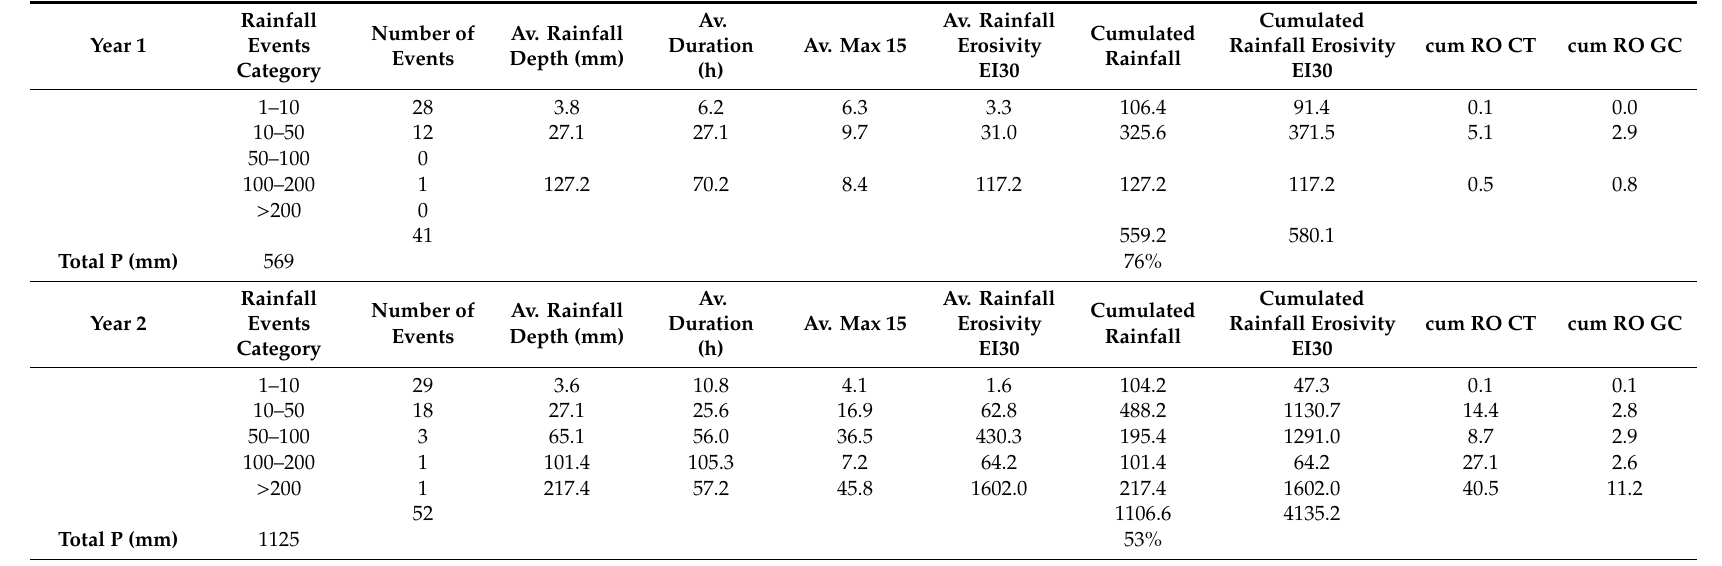
Table 3. Classification of rainfall events recorded in the two years of observation, with indication, for each class, of number of events, average rainfall depth (mm) and duration (h), average 15 min maximum intensity (mm h − 1 ), average rainfall erosivity (MJ ha − 1 ), cumulated (total for each class) rainfall (mm),